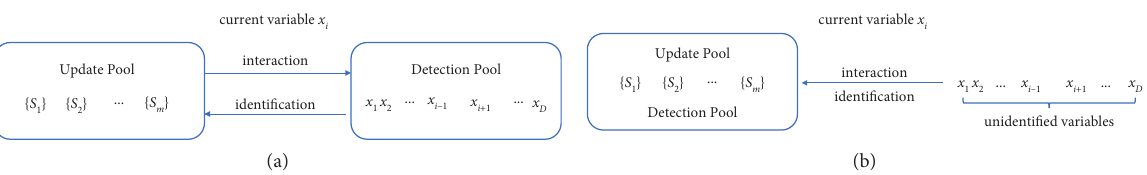
Figure 1: Decomposition framework. (a) Double-pool procedure. (b) Single-pool